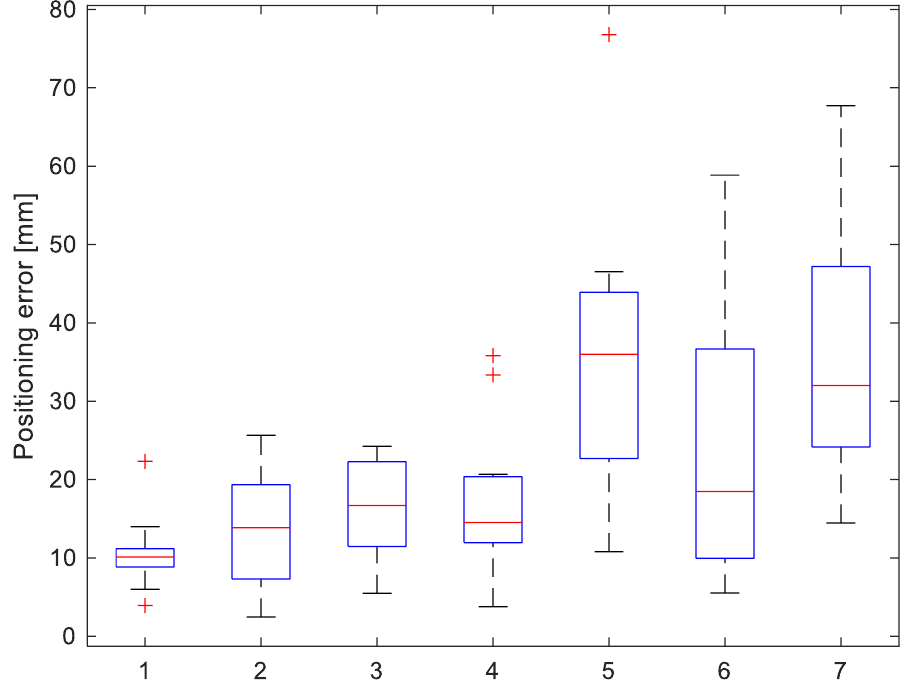
Figure 9. The boxplot of the positioning error.